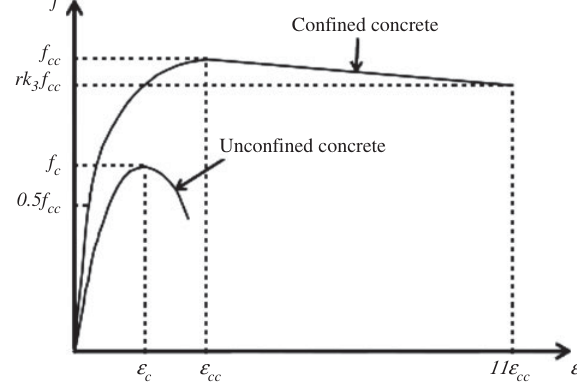
Fig. 2. Equivalent uniaxial stress-strain curves for concrete (Ellobody, Young